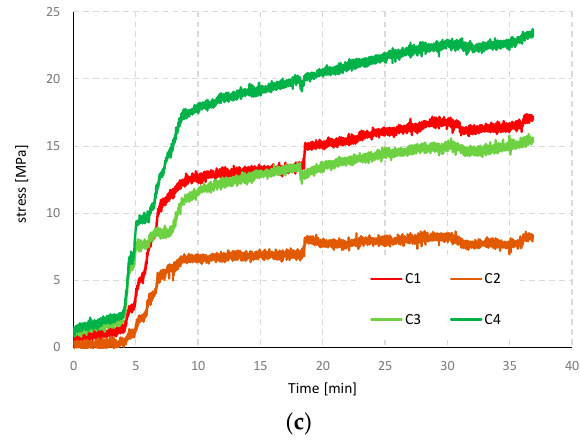
Figure 13. Strain measurements at rebars: ( a ) Position A; ( b ) Position B; ( c ) Position C (See Figure 12).